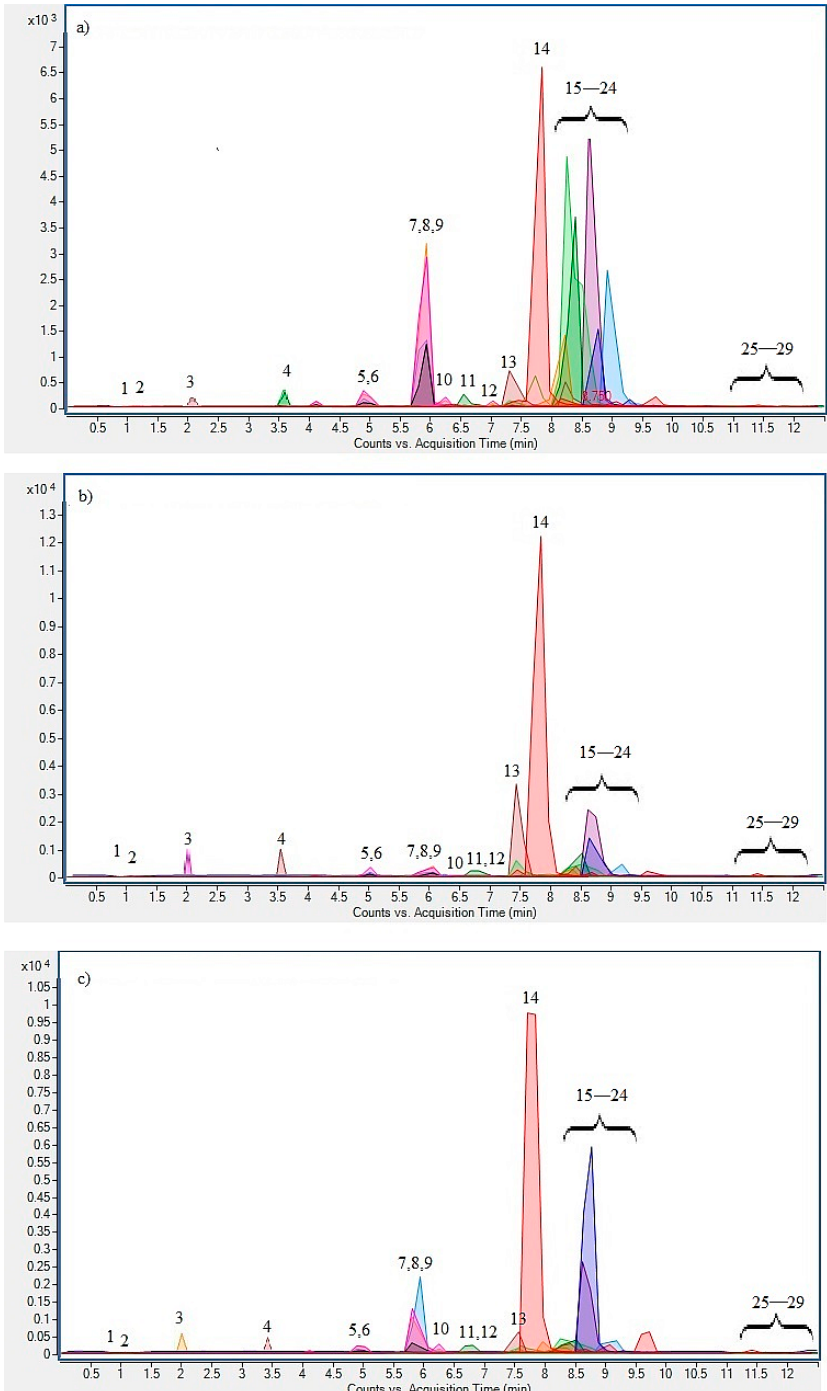
Figure 1. UPLC-MS/MS chromatogram in MRM acquisition mode of Laurus nobilis L. leaf extracts obtained by optimized extraction conditions of CRE ( a ), MAE ( b ) and UAE ( c ): (1) rosmarinic acid, (2) syringic acid, (3) 3,4-dihidrobenzoic acid hexoside, (4) protocatechuic acid, (5) chlorogenic acid, (6) p -hydroxybenzoic acid, (7) caffeic acid, (8) epicatechin, (9) catechin, (10) procyanidin trimer, (11) luteolin-6-C-glucoside, (12) kaempferol-3-O-deoxyhexoside, (13) p -coumaric acid, (14) rutin, (15) apigenin, (16) quercetin-3-glucoside, (17) ferulic acid, (18) luteolin, (19) kaempferol-3-rutinoside, (20) quercetin-3-pentoside, (21) kaempferol-3-O-hexoside, (22) isorhamnetin-3-hexoside, (23) quercetin-3-rhamnoside, (24) kaempferol-3-O-pentoside, (25) gallic acid, (26) apigenin-6-C-(O-deoxyhexosyl)-hexoside, (27) epicatechin gallate, (28) myricetin, (29) epigallocatechin gallate.